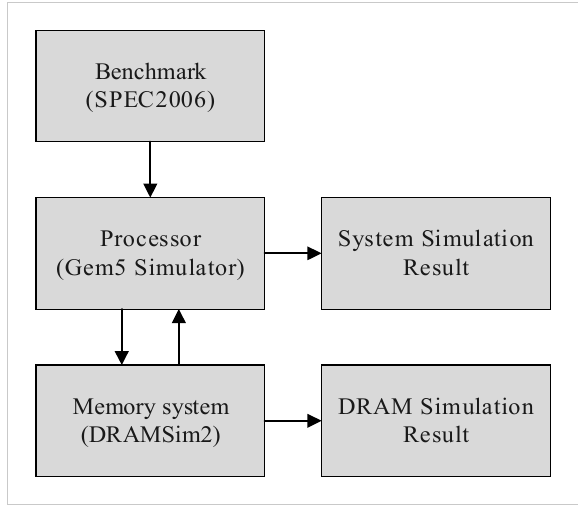
Figure 13. Evaluation flow. Table 3. System configurations.